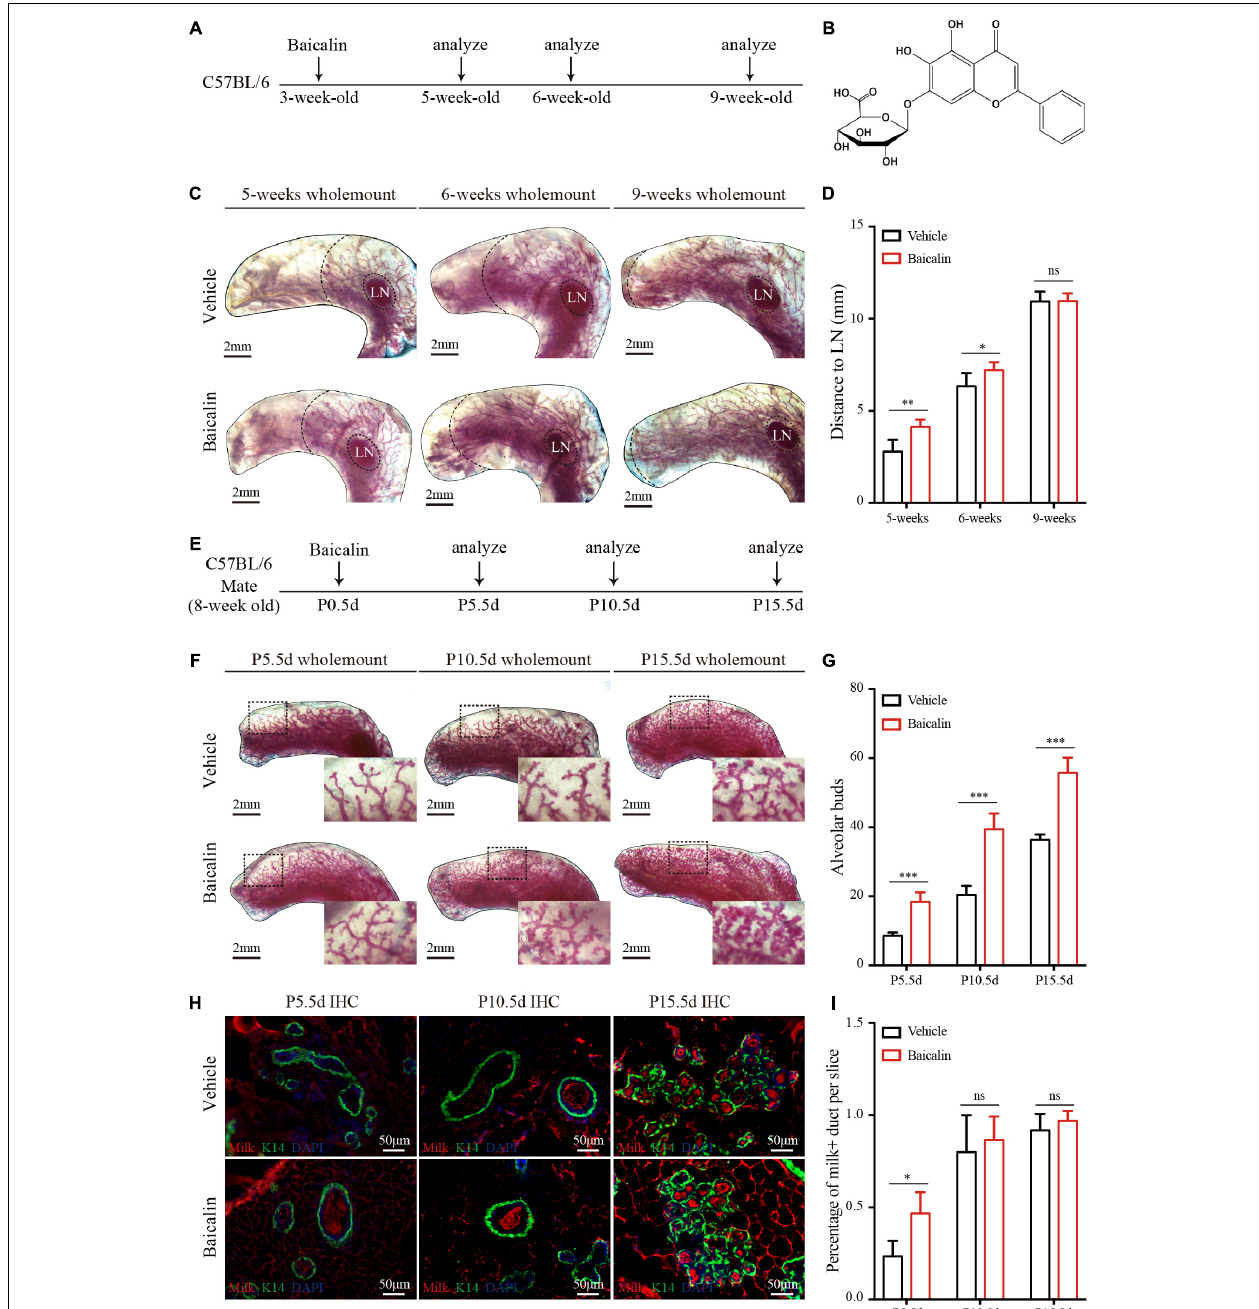
FIGURE 1 | Baicalin accelerates mammary development during puberty and pregnancy. (A) Illustration of the baicalin stimulation strategy using C57BL/6 mice from puberty to adulthood. The mice were treated with baicalin at the start of puberty, when the mice were 3 weeks old. The mammary glands were harvested from 5-, 6-, and 9-week-old mice. (B) The chemical structure of baicalin. (C) Wholemount carmine staining (red) of mammary glands isolated from 3- to 9-week-old female mice. The data represent three independent experiments. (D) Quantification of duct elongation indicates that baicalin accelerates the elongation of mammary gland ducts at 5 and 6 weeks, but not at 9 weeks. Student’s t -test: ** P < 0.01; * P < 0.05; ns, not significant. (E) Illustration of the baicalin stimulation strategy using C57BL/6 mice during pregnancy. To study the role of baicalin in pregnancy, pregnant 8-week-old mice were treated with baicalin at day 0.5 of pregnancy (P0.5d) every day until sample collection. The mammary glands were harvested at P5.5d, P10.5d, and P15.5d. (F) Wholemount carmine staining (red) of mammary glands isolated from pregnant female mice. The black box indicates the focal structure. The data represent three independent experiments. (G) Quantification of alveolar cells indicates that baicalin increases the formation of alveolar cells at P5.5d, P10.5d, and P15.5d. Student’s t -test: *** P < 0.001; ns, not significant. (H) Images of sections from pregnant mice showing milk secretion. Scale bar, 50 µ m. (I) Quantification of milk secretion indicates that baicalin can induce the production of milk at P5.5d, but not at P10.5d and P15.5d. Student’s t -test: * P < 0.05; ns, not significant.